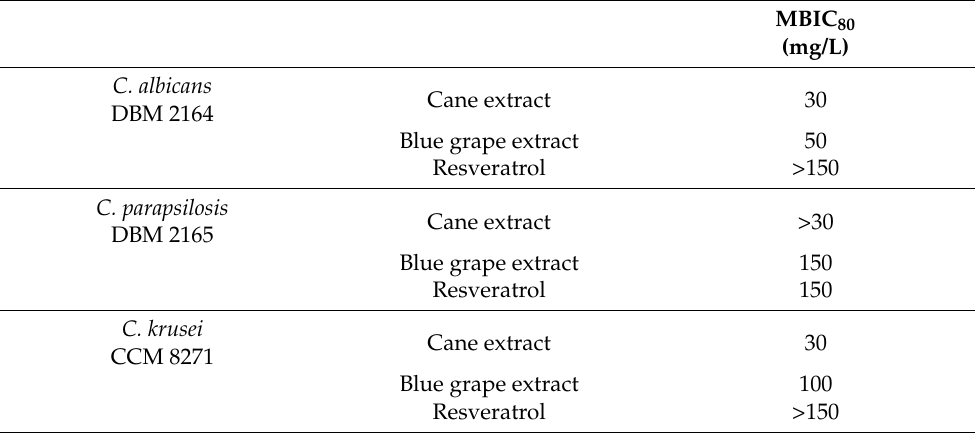
Table 2. Minimum biofilm inhibitory concentrations (MBIC 80 ) of blue grape extract, cane extract and resveratrol for C. albicans DBM 2164, C. parapsilosis DBM 2165 and C. krusei CCM